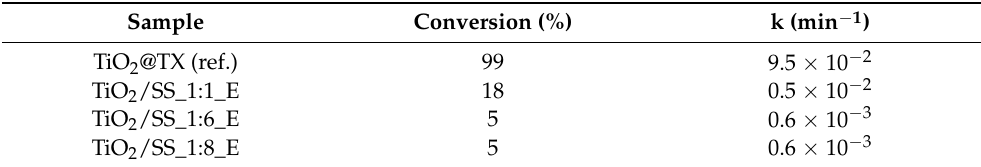
Table 4. Conversion (%) and kinetic constant (min − 1 ) obtained via photocatalytic tests of TiO 2 /SS_E samples prepared via